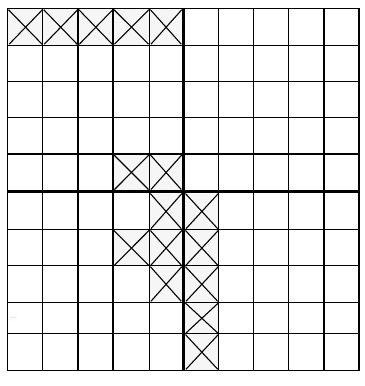
Figure 3. Pattern of enrolled land.